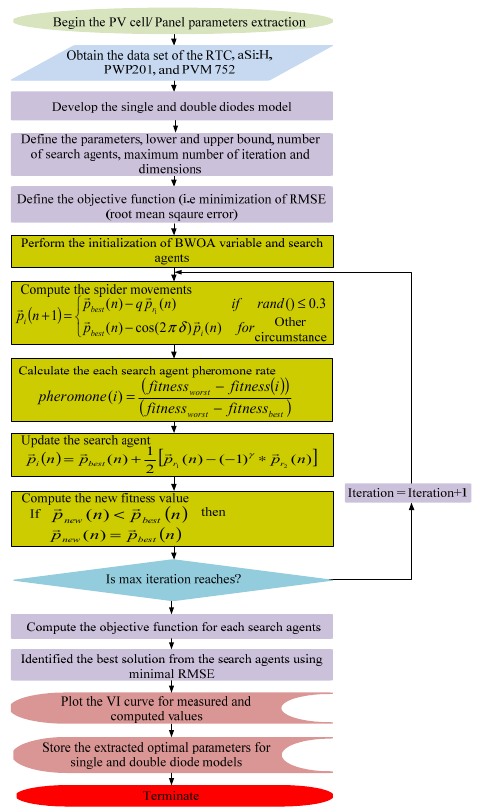
Figure 2. Flow chart of PV cell/panel parameter extraction using the BWOA.